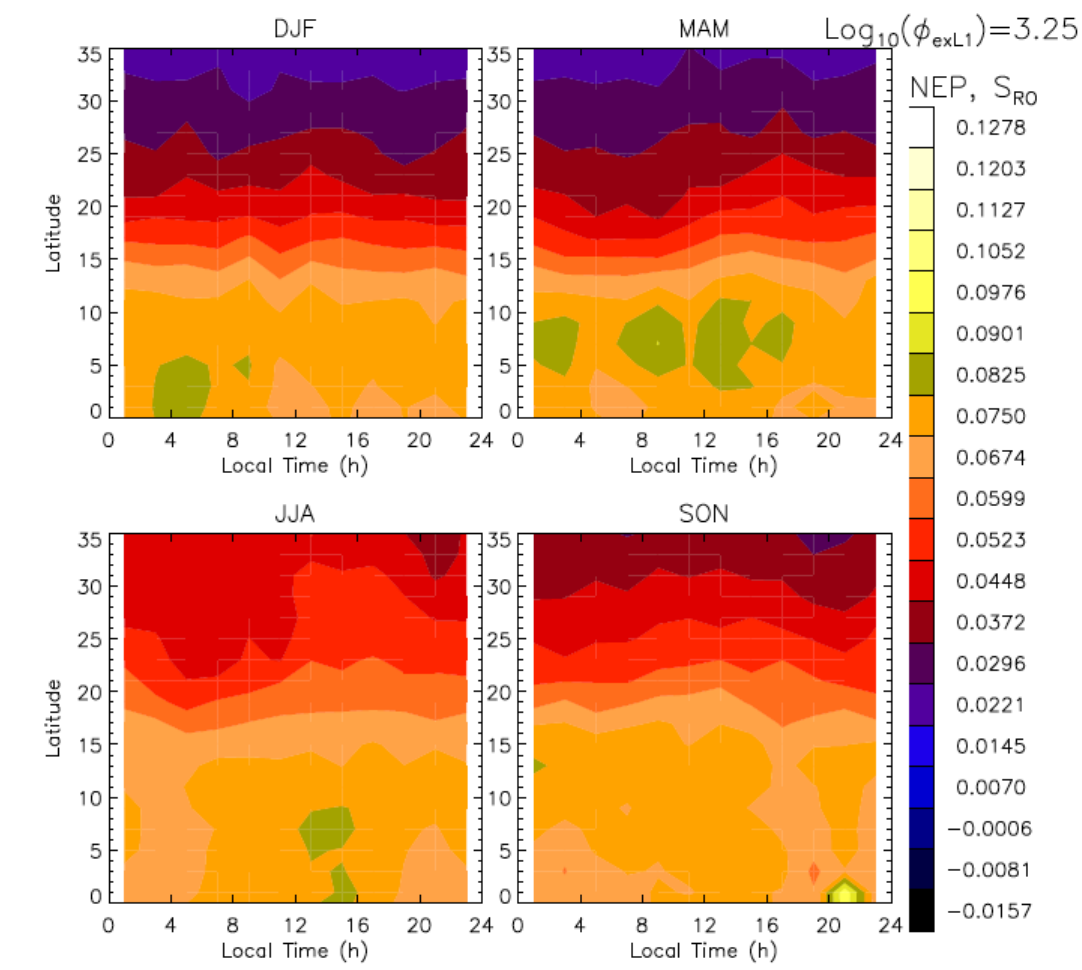
Figure 13. As in Figure 12 but for the NEP region (150° W–120° W).